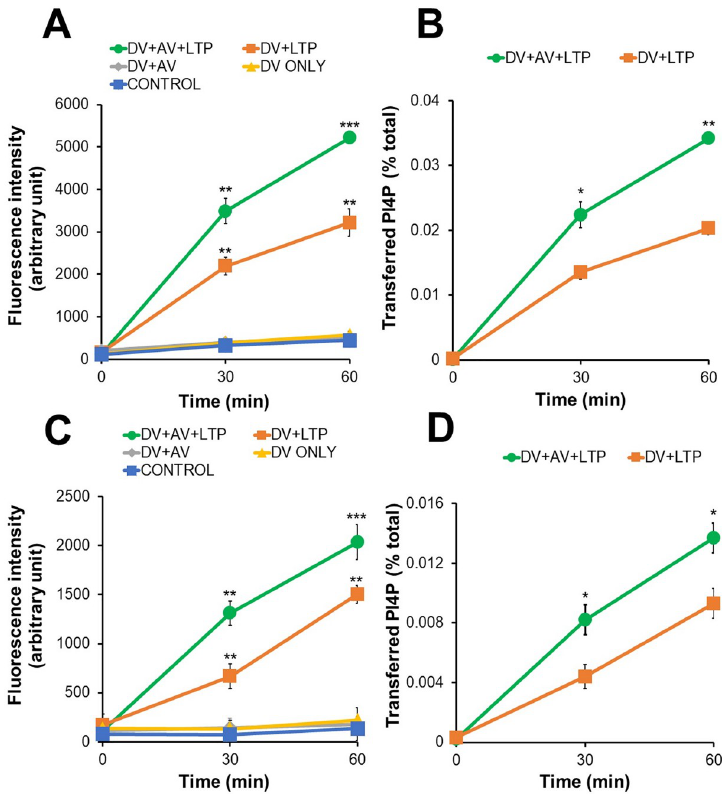
Fig 2. In vitro transfer of PtdIns4P from donor to acceptor vesicles in the presence of rEhLTP1 (A,B) and rEhLTP3 (C,D). Donor vesicles (DV) (1.5 μ l) containing PtdIns4P were incubated in separate reaction without acceptor vesicles (AV) and recombinant proteins (“DV ONLY”), with 0.5 μ g of either rEhLTP1 or rEhLTP3 (“DV +LTP”), with 3 μ l of AV (“DV+AV”), or with 3 μ l of AV and 0.5 μ g of either rEhLTP1 or rEhLTP3 (“DV+AV+LTP”) at room temperature. Fluorescence units were measured after 30 and 60 min of incubation. The percentage of transfer of PtdIns4P (B, D) were calculated from (A) and (C), respectively as described in Methods section. The experiments were conducted in duplicates three times (n = 3 with error bars indicating standard deviations). Statistical comparisons were made by Student’s t-test ( � P � 0.05, �� P � 0.005, ��� P � 0.0005). The y axis represents arbitrary fluorescence